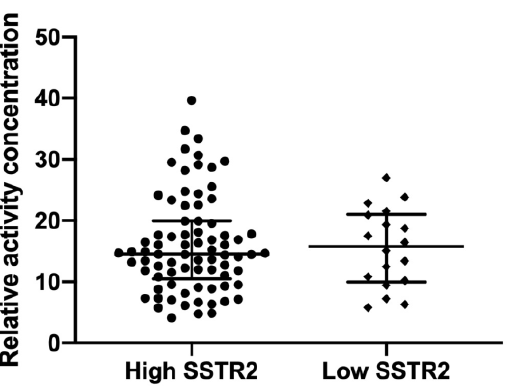
Figure 7. Relative activity concentration at SPECT 24 h after PRRT was estimated in 97 tumors from 33 patients: 27 with high and 6 with low SSTR2 expressing tumors. In each patient 2–3 tumors were measured, yielding 79 tumors in High SSTR2 and 18 tumors in Low SSTR2 groups, respectively. No significant difference was seen between the groups ( p = 0.99, Mann–Whitney U test). Bars show median and inter-quartile range.